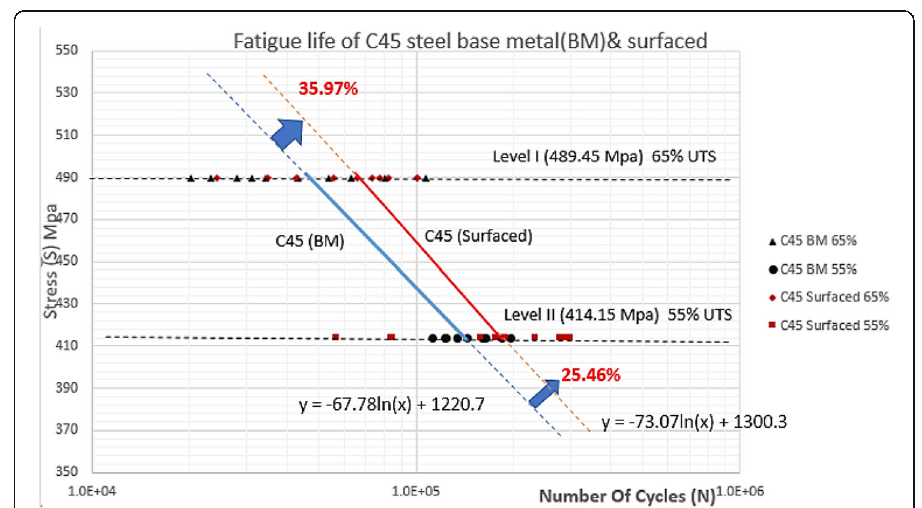
Fig. 4 Rotating bending fatigue results for C45 steel (BM and surfaced) at two levels of stress and the confidence levels for each